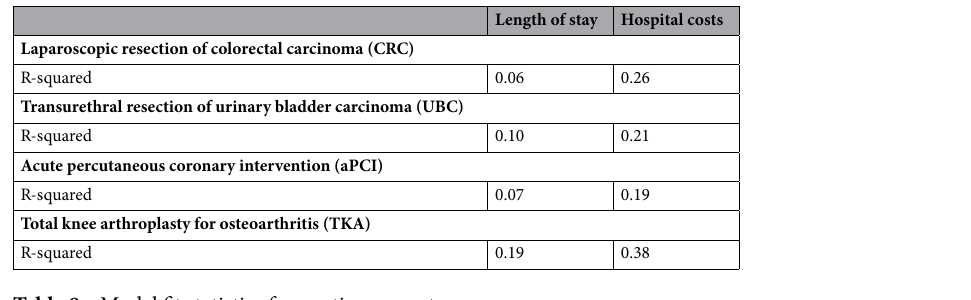
Table 8. Model fit statistics for continuous outcomes.